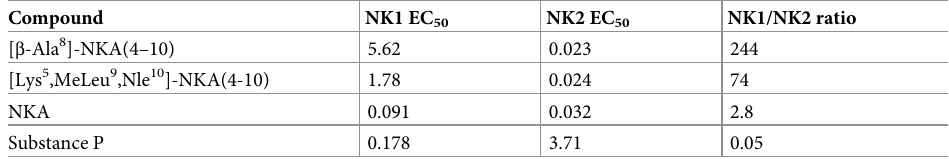
Table 6. Ratio of EC 50 s (in nM) for cAMP